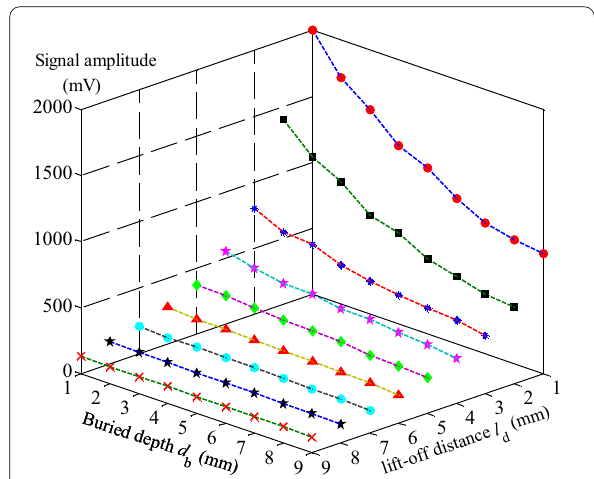
Figure 12 The normal component of leakage magnetic field of inner defect with buried depth d b of 1.0 mm and the sensor is placed at a lift-off distance l d of 1.0 mm